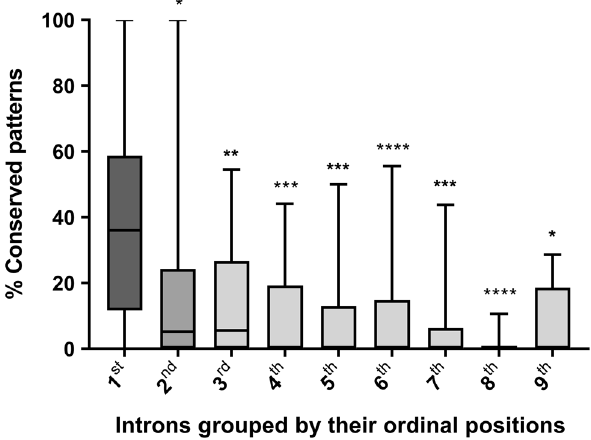
Figure 1: Percentage of sequence conservation for each intron group ( 1st to 9th ) from 25 genes generated from the NRS analysis. Mann – Whitney U statistical test was performed to assess the di ff erences of conserved sequences between di ff erent groups of introns ( * P < 0.05, ** P < 0.01, *** P < 0.001, **** P < 0.0001 ) .